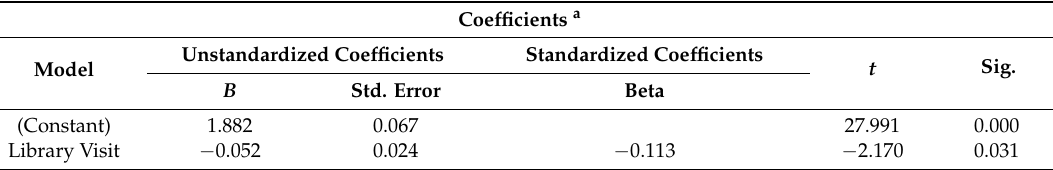
Table 5. Regression